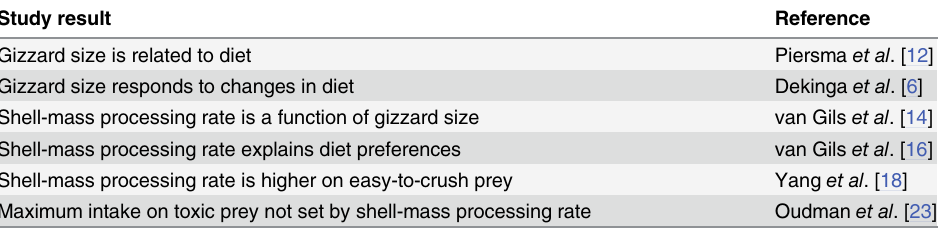
Table 1. Experimental studies on gizzard size and diet in red